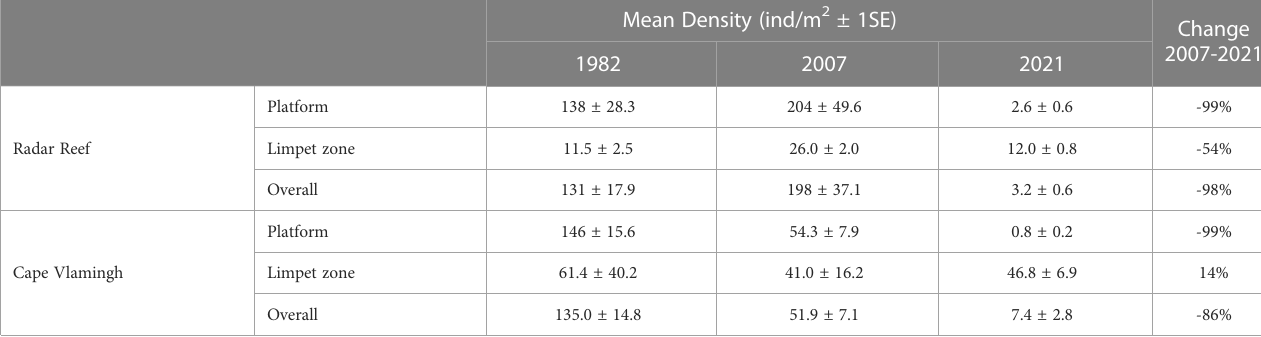
TABLE 2 Density of molluscs on intertidal platforms at Rottnest Island, Western Australia in 1982, 2007 and